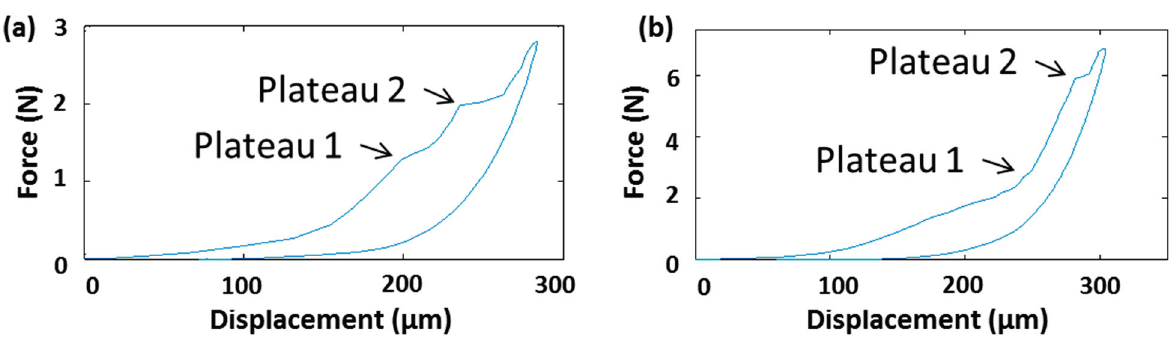
Figure 4. Examples of a force-displacement curve recorded by CSM microindentation on a single MN of a ceramic npMNA received from production run 2.6. ( a ) Force displacement curve clearly depicting the two plateaus of initial crack fracture (plateau 1) and at the full failure fracture (plateau 2); ( b ) curve with a less pronounced plateau